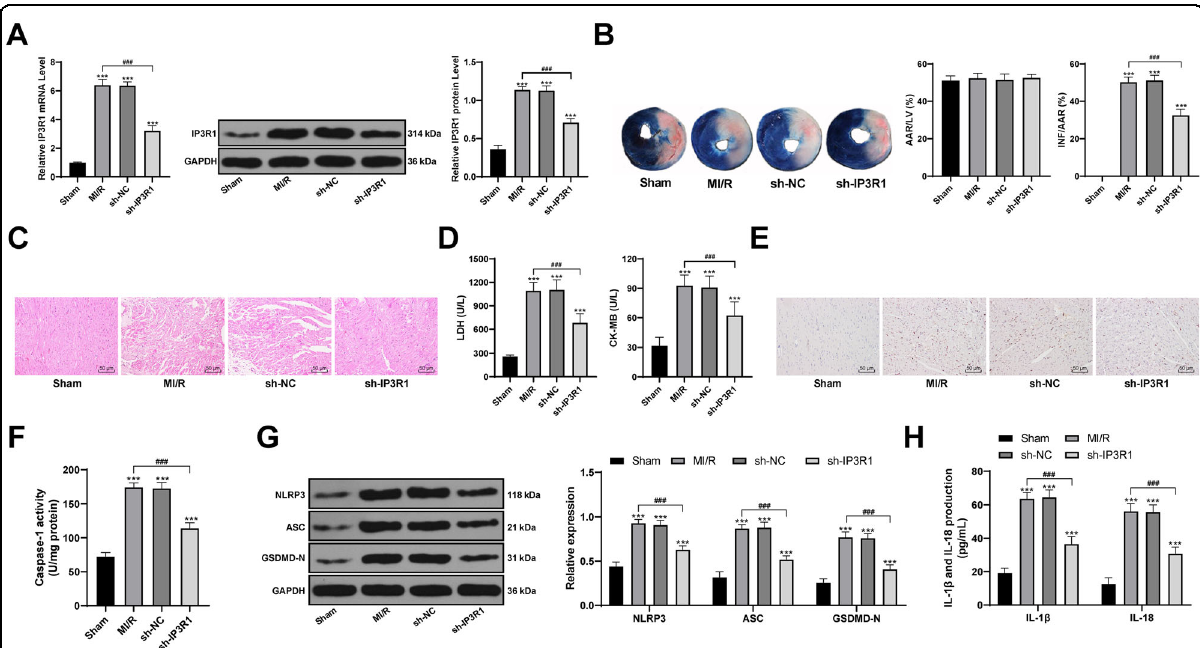
Fig. 1 Inhibition of IP3R1 reduces MI/R-induced pyroptosis and alleviates myocardial injury. A RT-qPCR and western blot were used to detect the levels of IP3R1 in the myocardium of rats after MI/R and shRNA intervention; B TTC staining was used to detect the infarct size of MI/R rats. AAR/ LV re fl ects the degree of ischemia, INF/AAR re fl ects the degree of infarction, n = 3; C HE staining was used to observe the pathological changes of myocardium of MI/R rats, n = 6. D the effect of IP3R1 on the concentration of myocardial enzymes in MI/R rats, n = 21; E immunohistochemical observation of GSDMD-positive expression, n = 6; F colorimetric method was used to detect the activity of Caspase-1, n = 6; G Western blot detected the levels of NLRP3, ASC, and GSDMD-N, n = 6; H ELISA was used to measure the levels of IL-1 β and IL-18, n = 6; compared with the sham